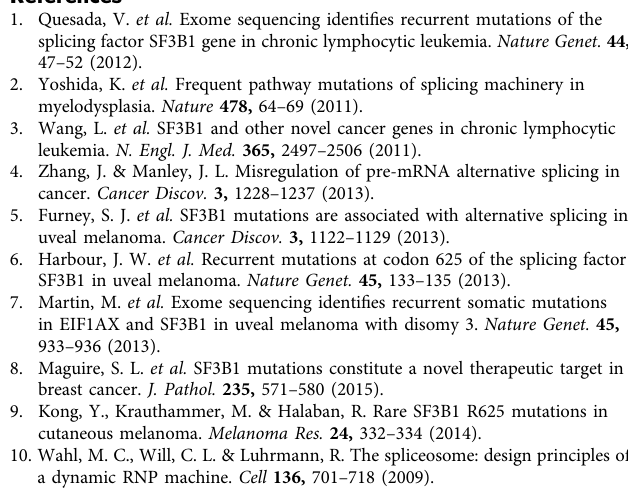
BP mutant constructs . Mutations of potential BP in TMEM14C and ENOSF1 ExonTrap constructs were introduced using QuikChange II Site